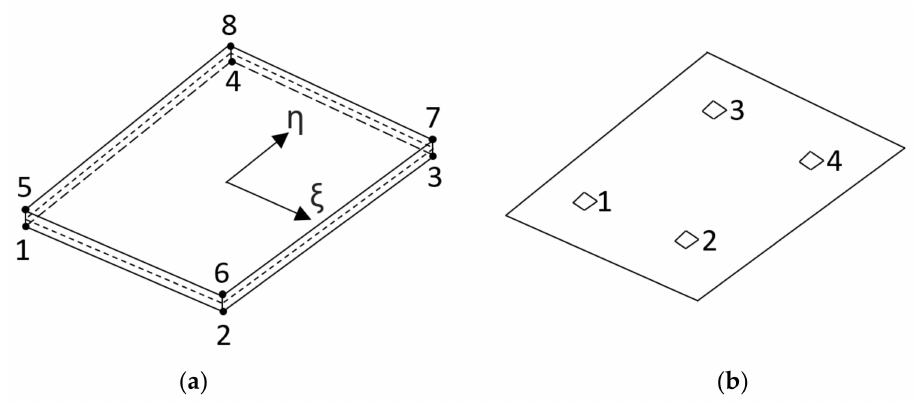
Figure 5. MSC Marc element 188: connectivity ( a ) and Gauss integration points ( b )